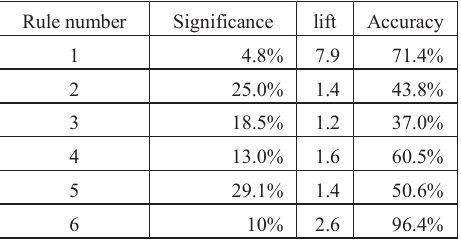
Table 12. Extracted rule evaluation from Stage 2 - Case